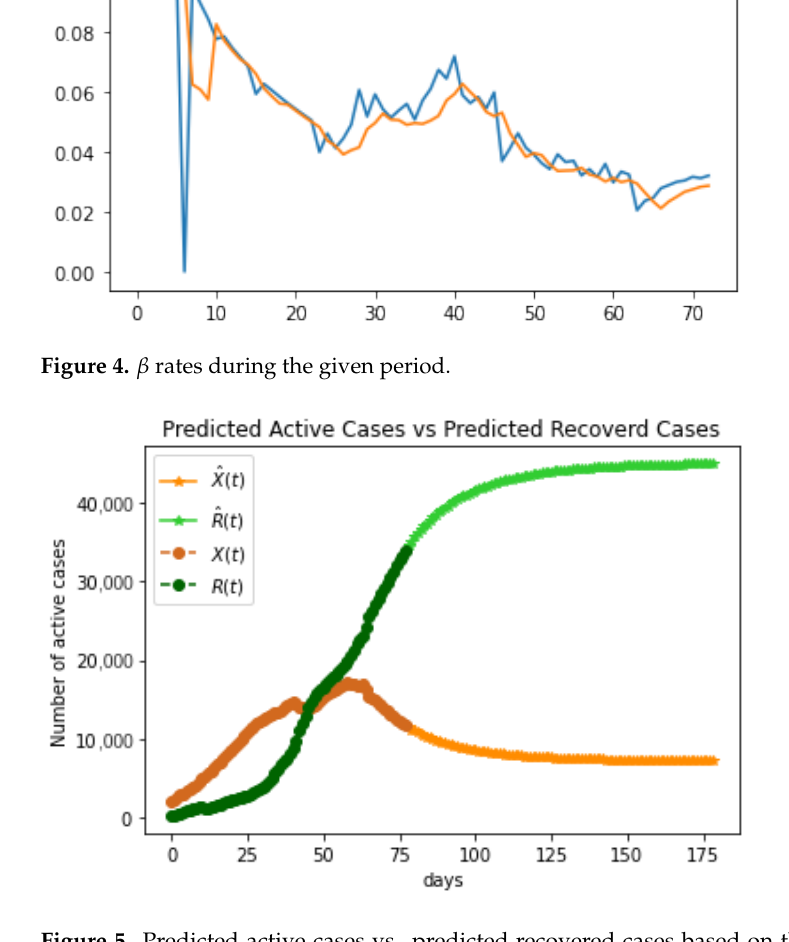
Figure 5. Predicted active cases vs. predicted recovered cases based on the time-dependent SIR model. X ( t ) is the actual number of infected (active) cases; ¯ X ( t ) is the predicted number of infected cases; R ( t ) is the real number of recovered cases; and ¯ R ( t ) is the predicted number of recovered